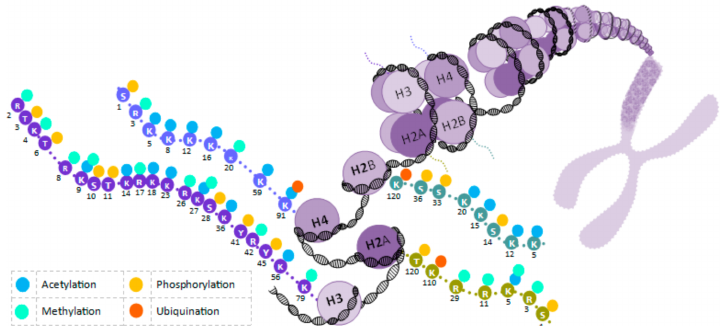
Figure 2. Histone modifications: Histones are proteins that package DNA into nucleosomes. Every nucleosome contains two subunits each of histones H2A, H2B, H3, or H4. These histones have an N-terminal tail where the covalent modifications preferentially occur. These modifications can be acetylation/deacetylation, methylation, phosphorylation, or ubiquinitation. All of these modifications can be related to different effects on the biology of the organism. Histone acetylation is triggered by the addition of an acetyl group and is involved in various cell processes such as chromatin dynamics and transcription, and apoptosis, among others. Histone methylation occurs via the addition of a methyl group and causes transcription repression or activation, depending on target sites. Histone phosphorylation happens when a phosphate group is added to the histone; it is involved in DNA repair, cell cycle progression, chromosome condensation, and apoptosis. Histone ubiquitination happens with the transport of ubiquitin to the histone core proteins and can either activate or inhibit target gene expression, depending on which histone is affected. Figure by Gabriela Olivares-Castro [61].